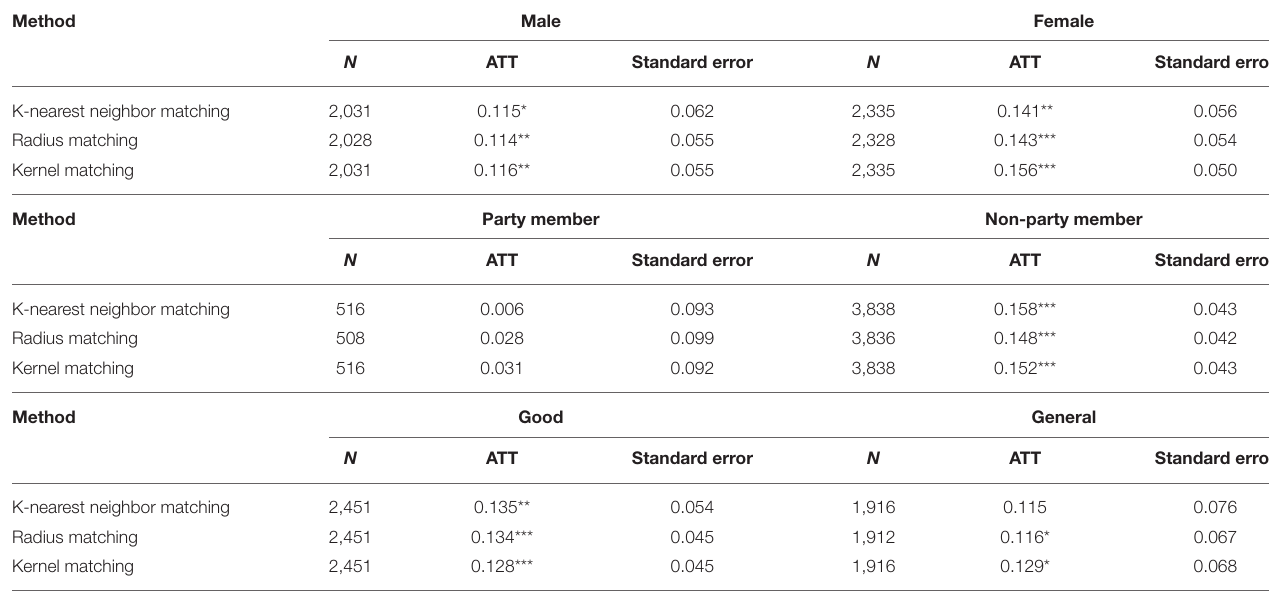
TABLE 6 | Heterogeneity test results.